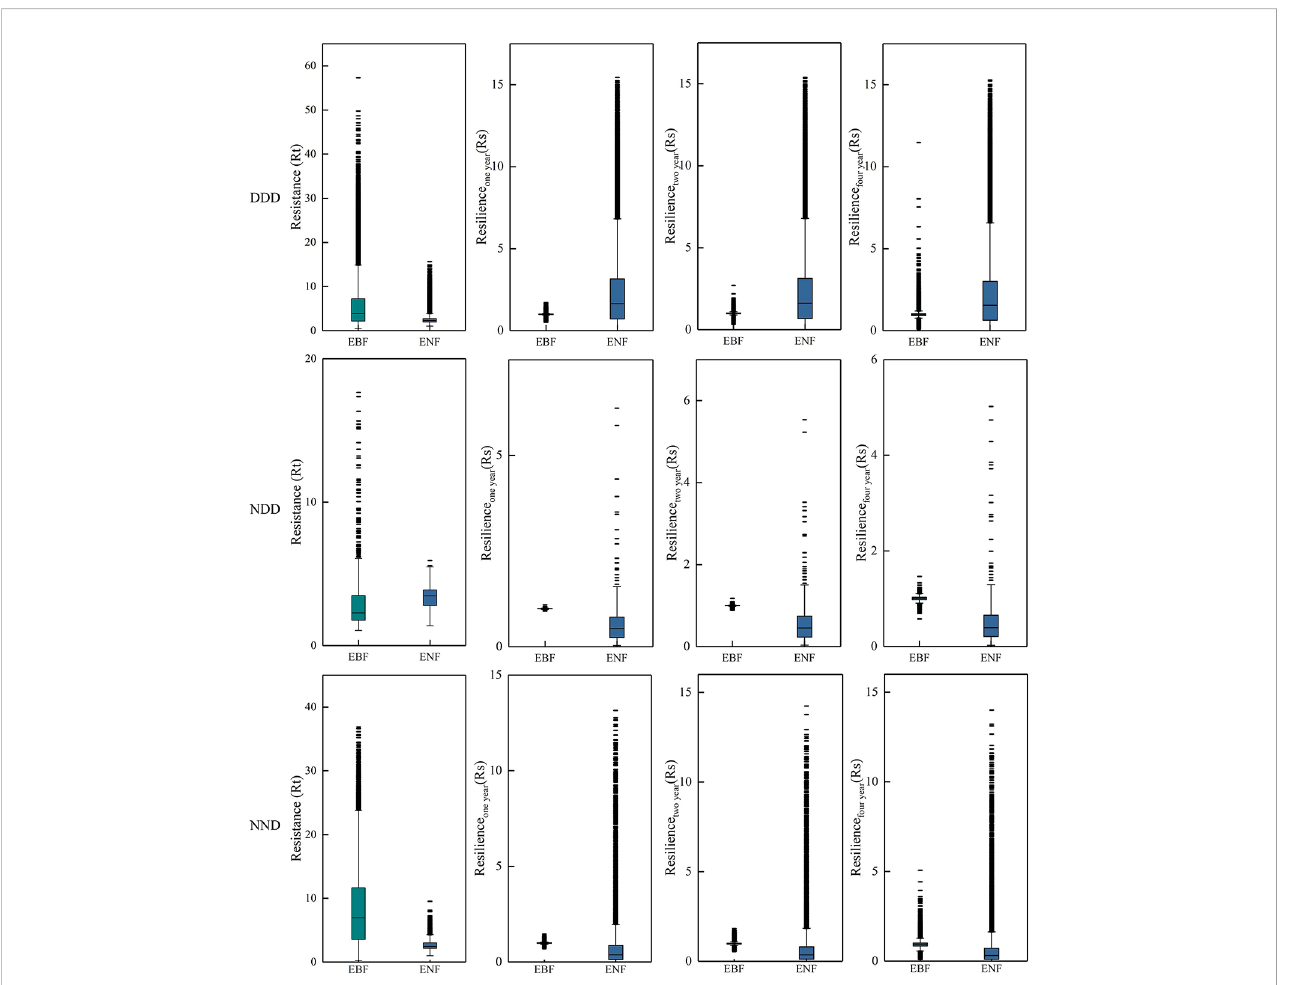
FIGURE 10 Statistical of Rt and Rs of two typical subtropical forests during and after the 2011 extreme drought. Each row represents a different combination of droughts. “ N ” represents normal, “ D ” represents drought, and “ NDD ” represents pixels that were normal in 2009 but drought in 2010 and 2011, i.e., pixels that suffered drought for two consecutive years. The fi rst column shows the Rt in 2011, and columns two to four show the resilience of the fi rst, second, and fourth years after the